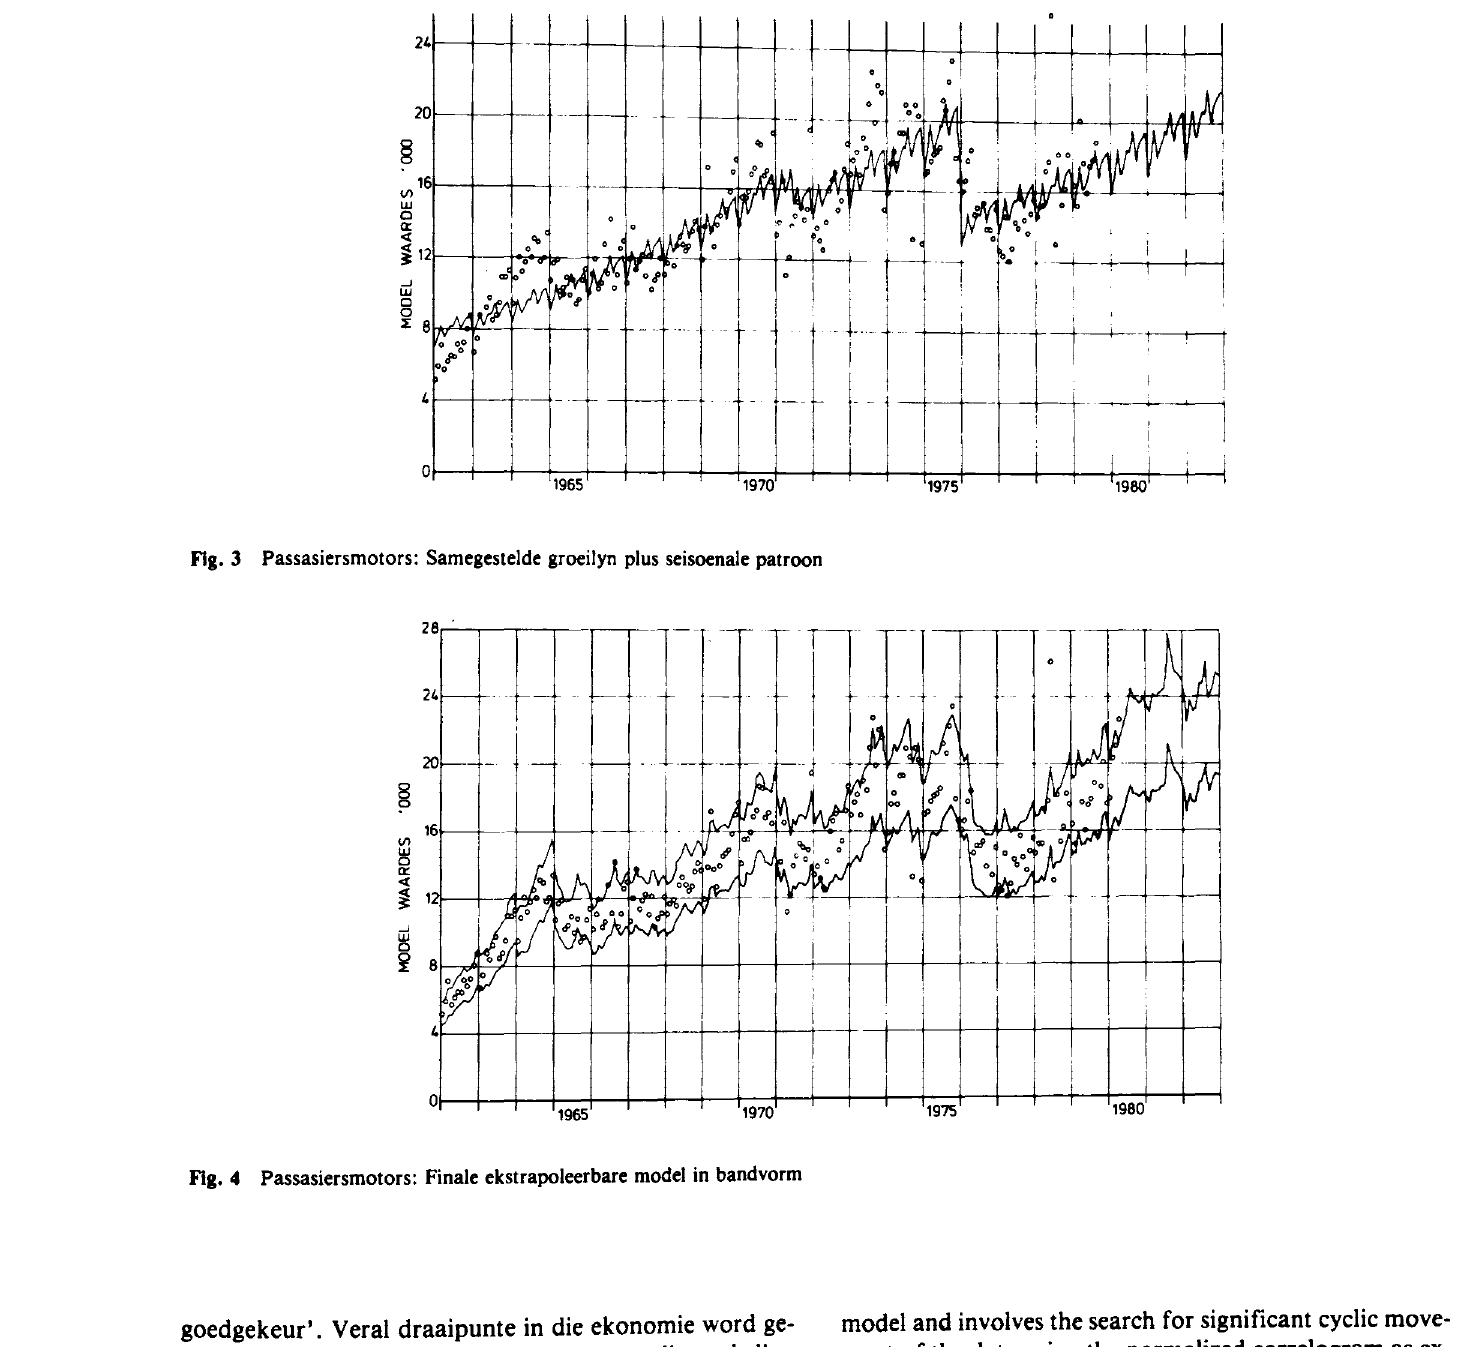
Fig. 3 Passasiersmotors: Samegestelde groeilyn plus seisoenale patroon